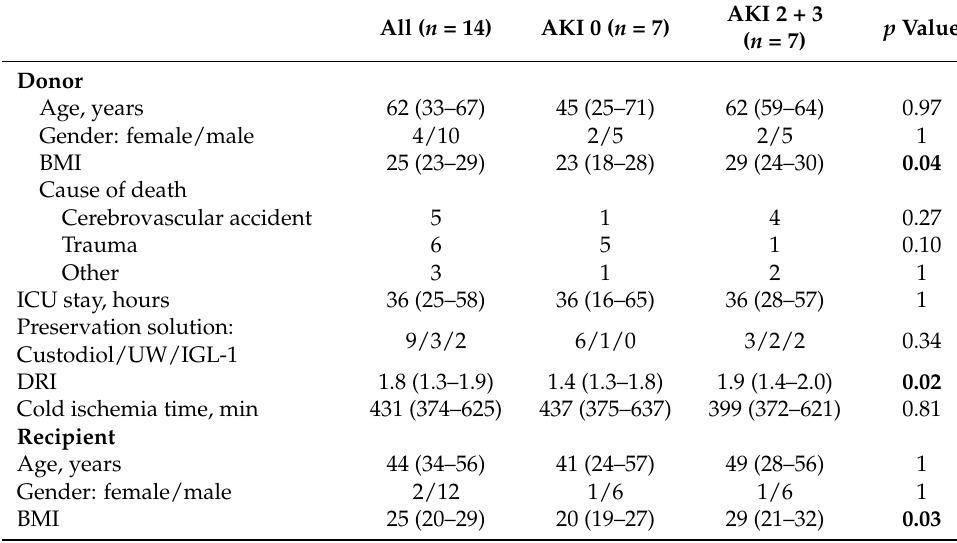
Table 1. Donor and recipient characteristics. Data are given as n (%) or median (IQR). * Etiologies